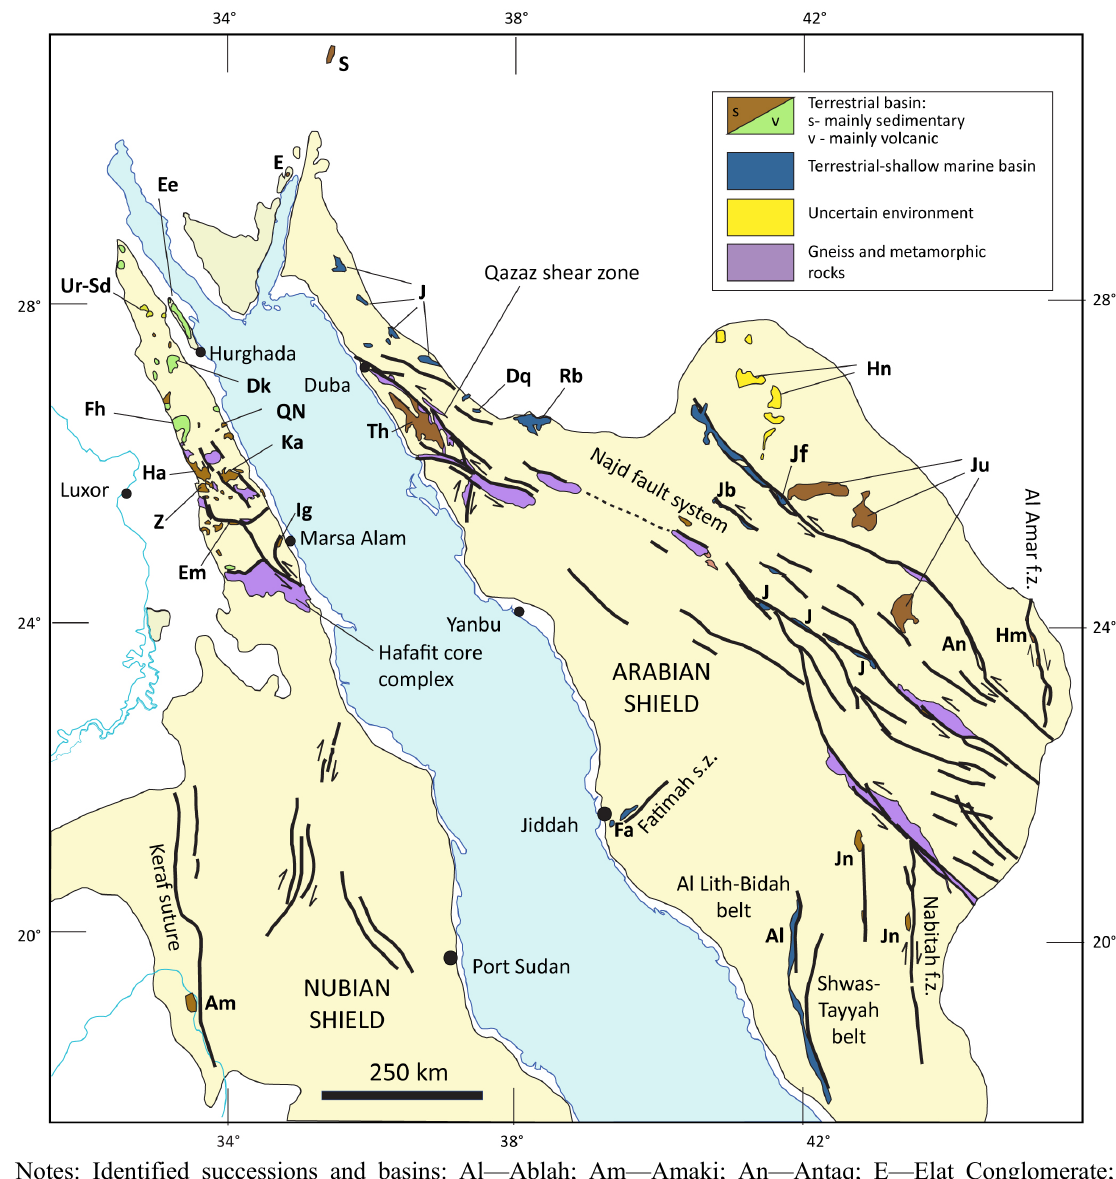
Figure 18. Ediacaran sedimentary and volcanic basins in the Arabian-Nubian Shield, showing their common juxtaposition to shear zones, gneiss belts, and core complexes (gneiss domes) (after